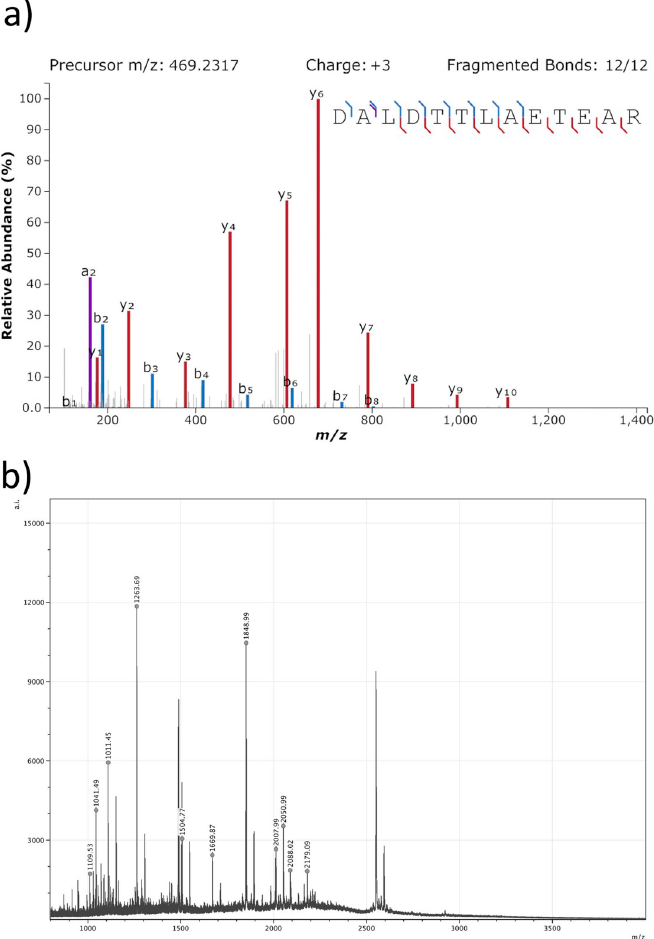
Spectral Annotator [33]. Panel B: PMF spectrum from Hvileh ø j C4273-97, fragment 19 which is specific to beaver based on the peaks 1669, 2050, and